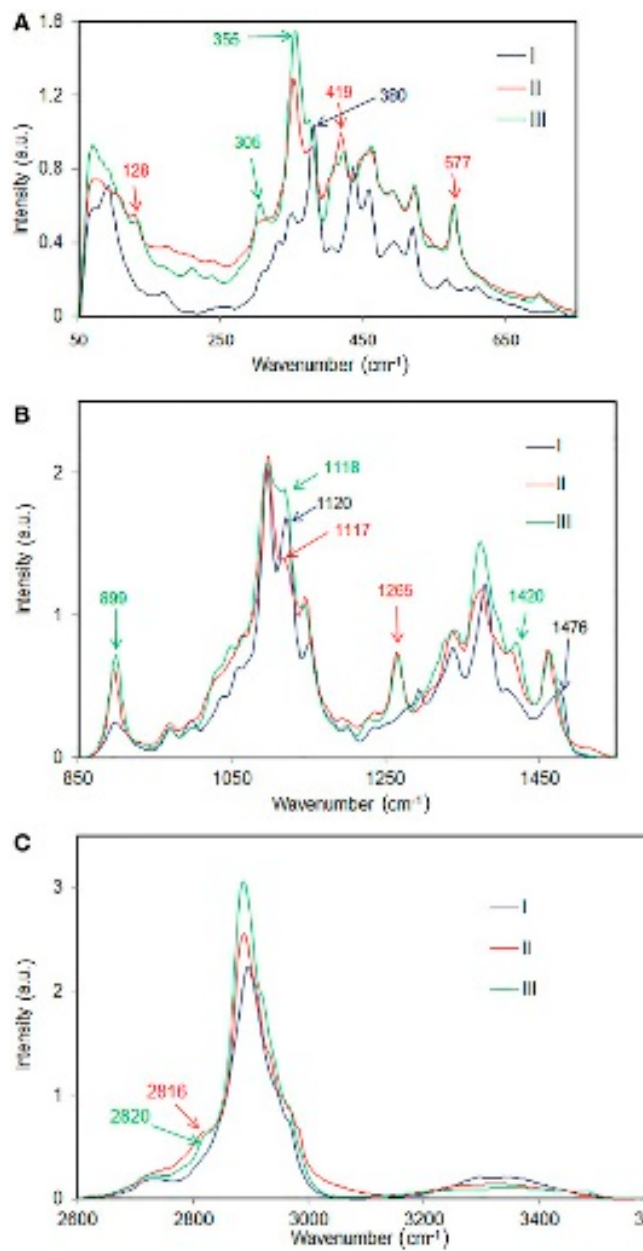
Figure 1. Comparison of Raman spectra of cellulose I, cellulose II, and cellulose III in various spectral regions; ( A ) 50–750 cm − 1 , ( B ) 850–1550 cm − 1 , ( C ) 2600–3600 cm − 1 . Reproduced from Ref. [13].